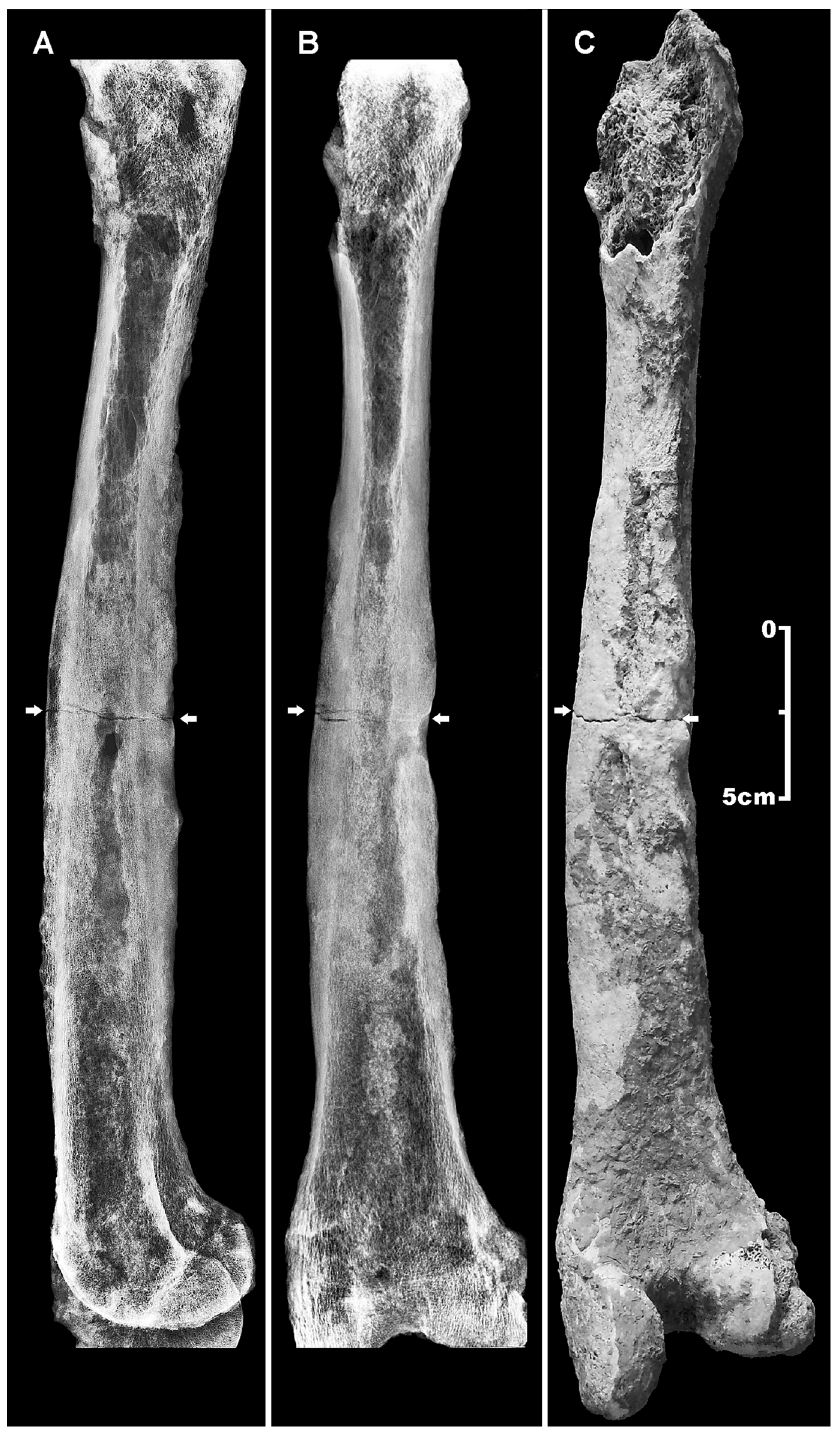
Fig 7. Traumatic and osteomyelitic femoral lesions. Latero-lateral (A) and antero-posterior (B) X-ray images, and posterior view (C) of the right femur (A, B). Diffuse periosteal new bone apposition ( involucrum ) testified by a more radiolucent enlarged cortical bone layer, a reduced medullary cavity, and a cloaca drainage canal, diagnostic of long-term chronic osteomyelitis (C). Abnormal size of the femoral shaft induced by periosteal new bone apposition. At the mid-shaft, the fracture line and the cloaca opening are evident (arrows). Scale bar equals 5